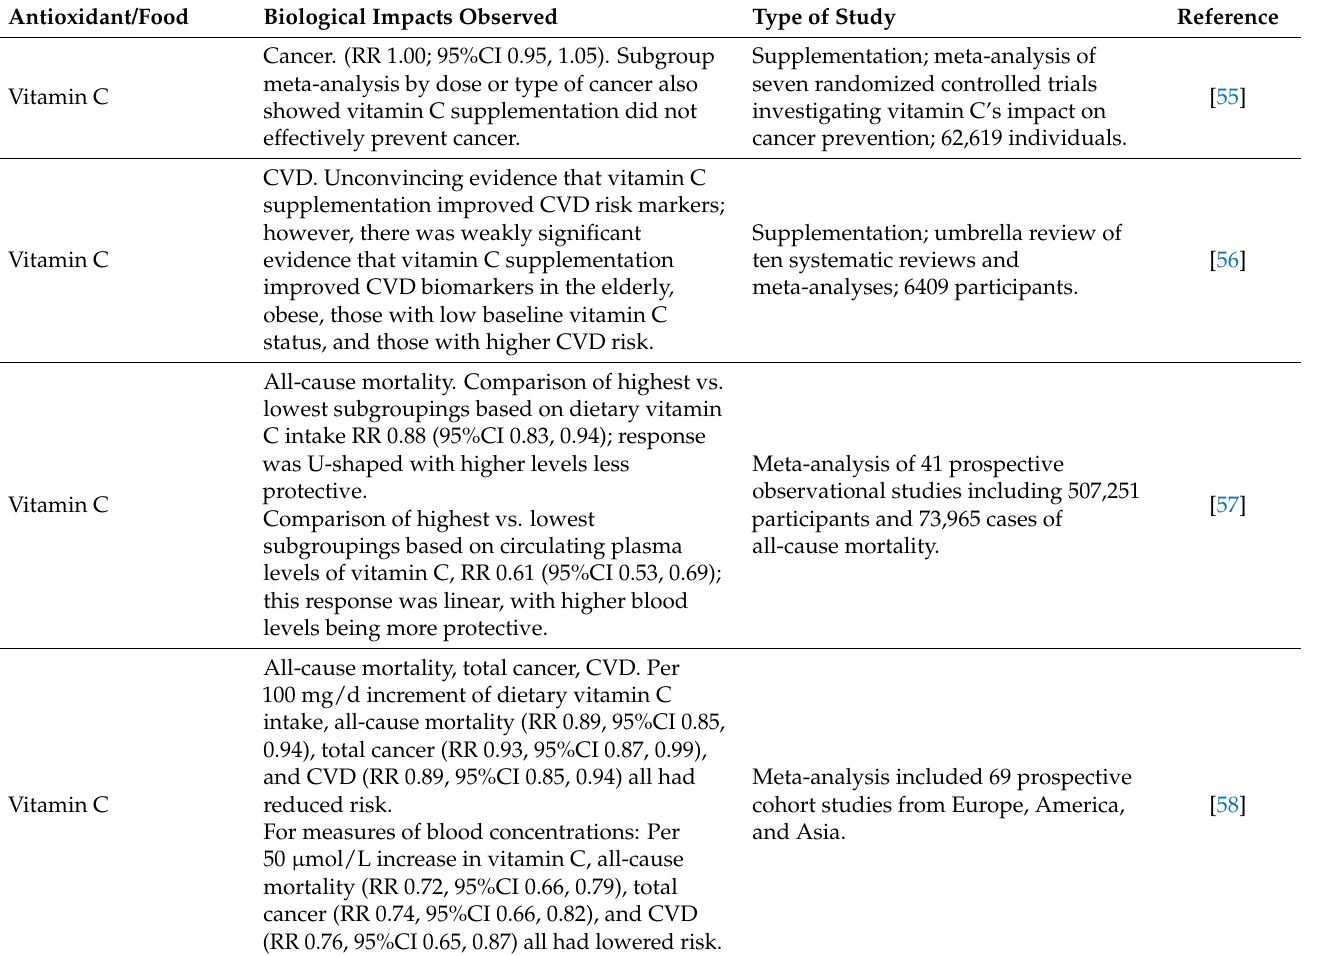
Table 1. Parameters and pertinent results from cited studies examining health outcomes associated with vitamin C. RR = Relative risk, CVD = cardiovascular